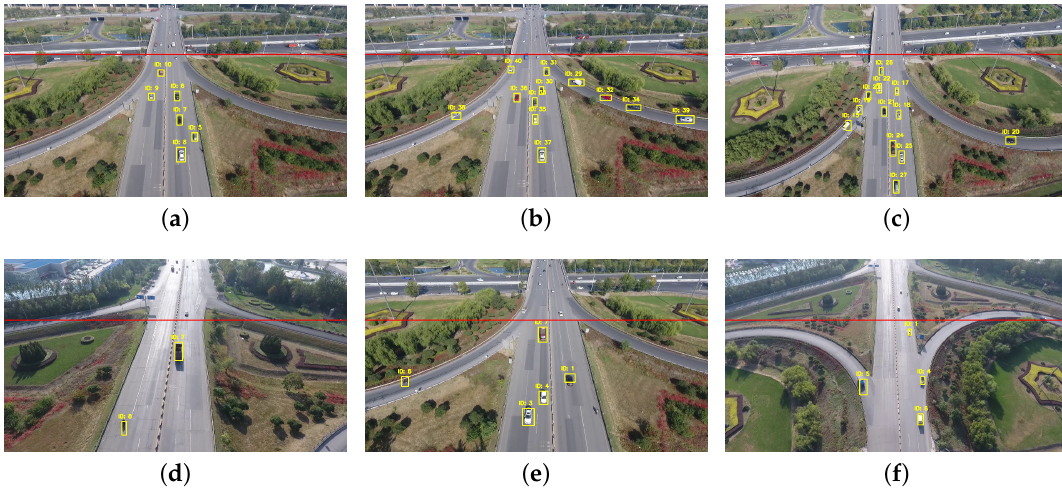
Figure 17. The vehicle tracking results on test aerial video: ( a – c ) captured with camera fixed; ( d – f ) captured with camera moving; ( a , b , d , e ) captured at a height of 50 m; and ( c , f ) captured at a height of 100